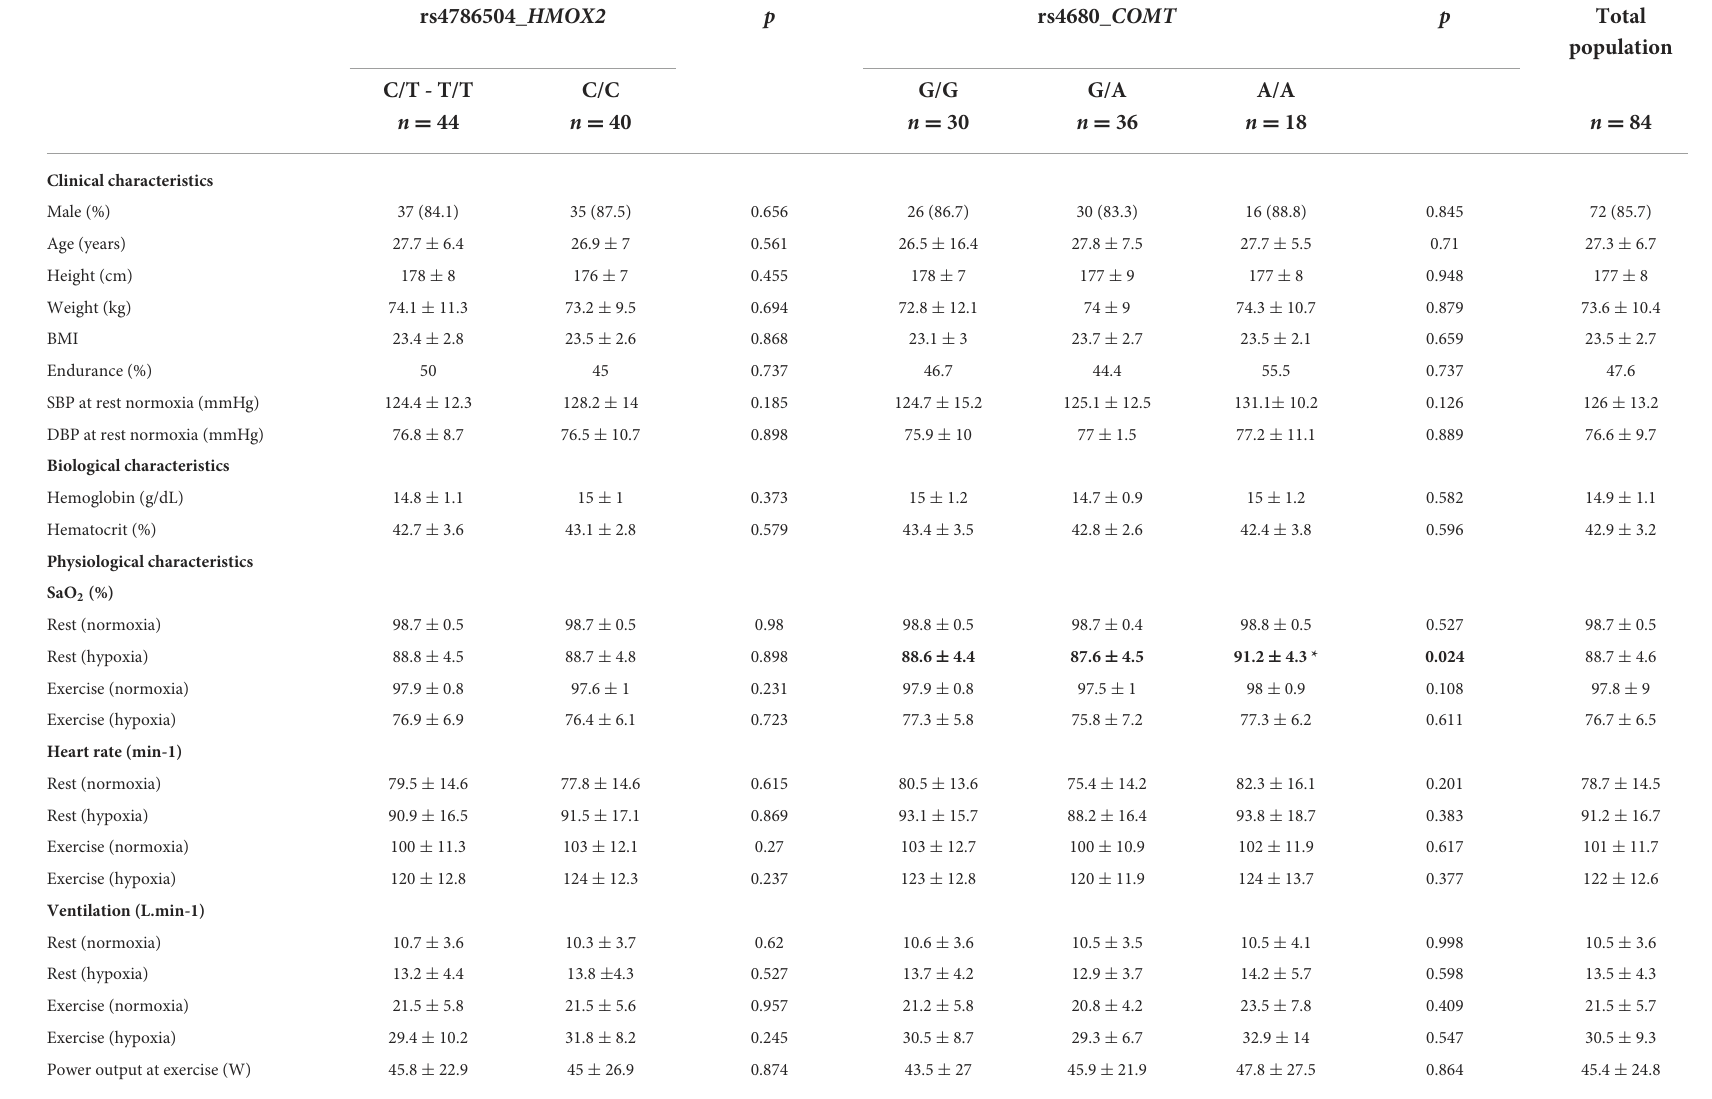
TABLE 2 Clinical, biological and physiological characteristics of subjects according to HMOX2 and COMT